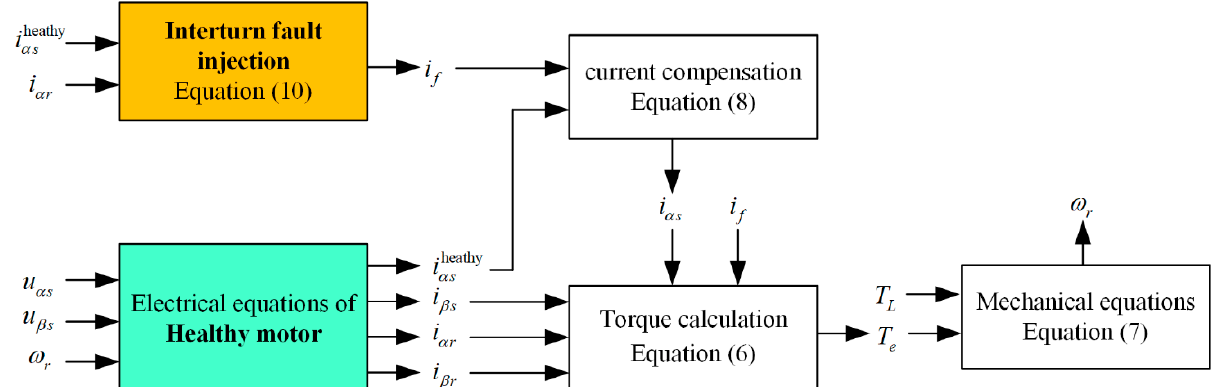
Figure 2. Block diagram of induction motor with interturn fault injection.